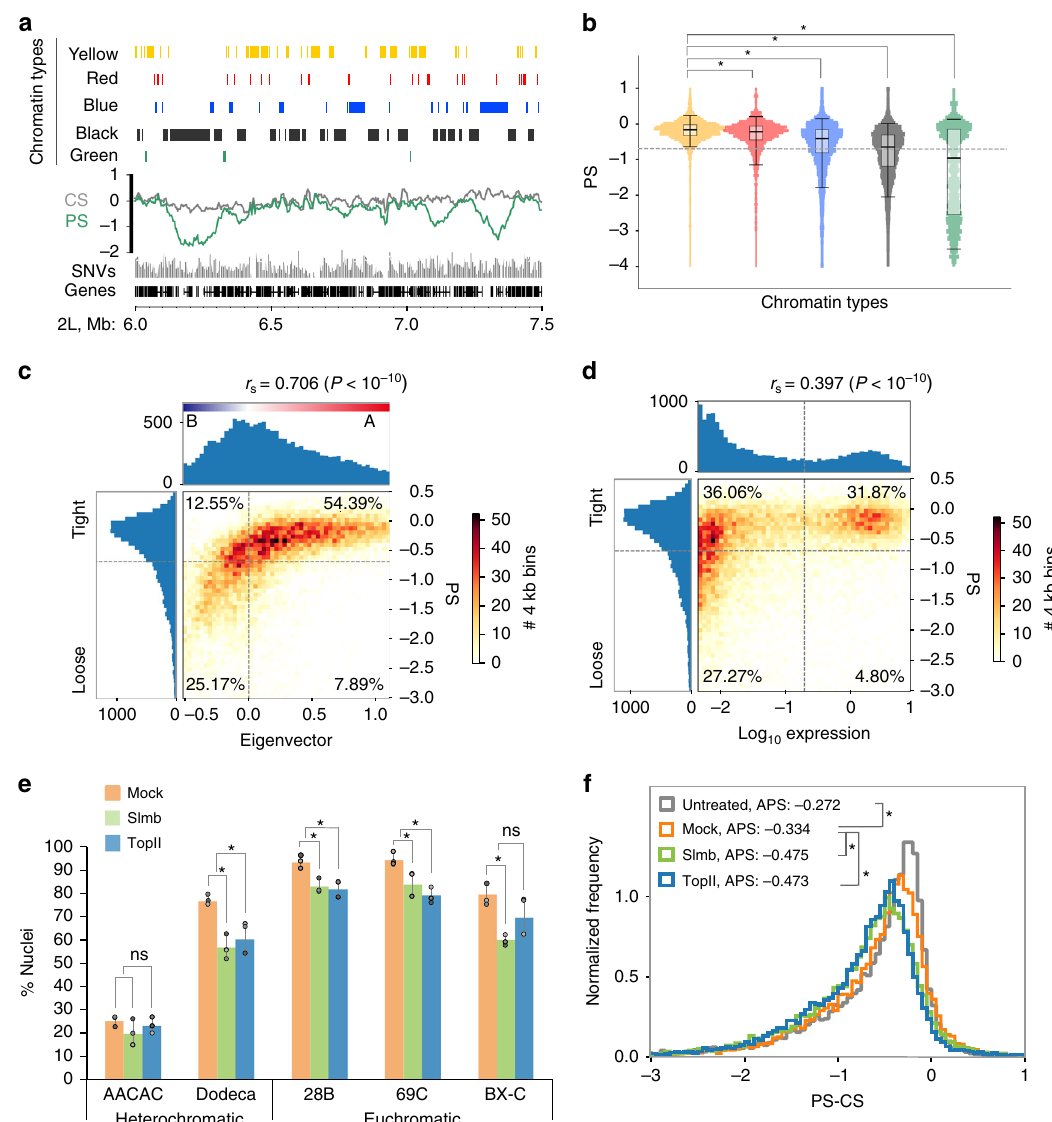
Fig. 3 Pairing in PnM cells is correlated with active genomic regions and can be disrupted by RNAi. a 1.5 Mb region of 2 L: Pairing scores (PS) and cis scores (CS) shown in a genome browser as compared to chromatin types identi fi ed in Kc 167 cells 45 and with SNVs in PnM cells. b Normalized distributions of PS within regions of different chromatin types. Dashed line shows the threshold between tight and loose pairing. * p < 1 − 10 , Mood ’ s test against yellow chromatin. c Distribution of PS values relative to the eigenvector shows that pairing is correlated with compartmentalization, A-type compartments being almost exclusively tightly paired, Spearman ’ s correlation coef fi cient ( r s ) = 0.706, p < 10 − 10 . d Distribution of PS values relative to gene expression in PnM cells shows that expressed genes are almost exclusively tightly paired, Spearman ’ s correlation coef fi cient ( r s ) = 0.397, p < 10 − 10 . e Levels of pairing (quanti fi ed and displayed as in Fig. 1d, in PnM cells after Slmb and TopII knockdown showed a reduction as compared to the control (mock) at all loci (* P < = 0.05, unpaired t -test) except for the AACAC satellite repeat and, in the case of TopII knockdown, at BX-C (ns, non-signi fi cant; error bars, s.d for three biological replicates; for N > 100 nuclei/replicate). Source data are provided as a Source Data fi le. f After Slmb and TopII knockdown, the aggregated pairing score (APS) values were reduced by 0.203% and 0.201%, respectively, as compared to untreated sample ( p < 0.001) and 0.141% and 0.139%, respectively, as compared to mock ( p < 0.001). The 0.062% reduction in mock as compared to untreated samples was also signi fi cant ( p < 0.001). p -values determined using bootstrapping